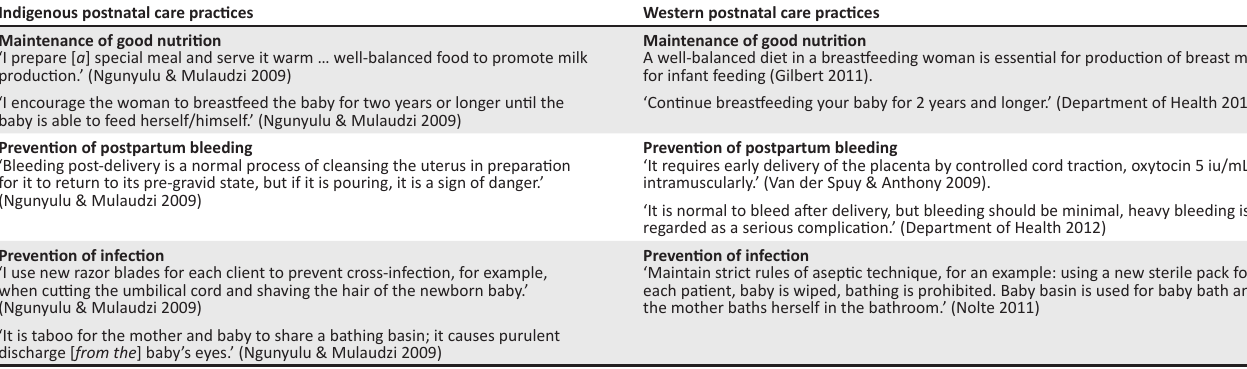
TABLE 1: Similarities between indigenous and Western postnatal care practices. Indigenous postnatal care